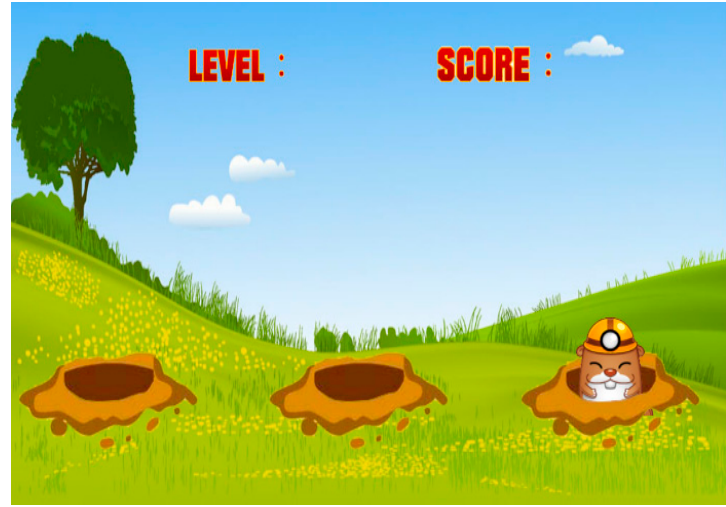
Figure 1. Screenshot demonstration of the whack-a-mole game.